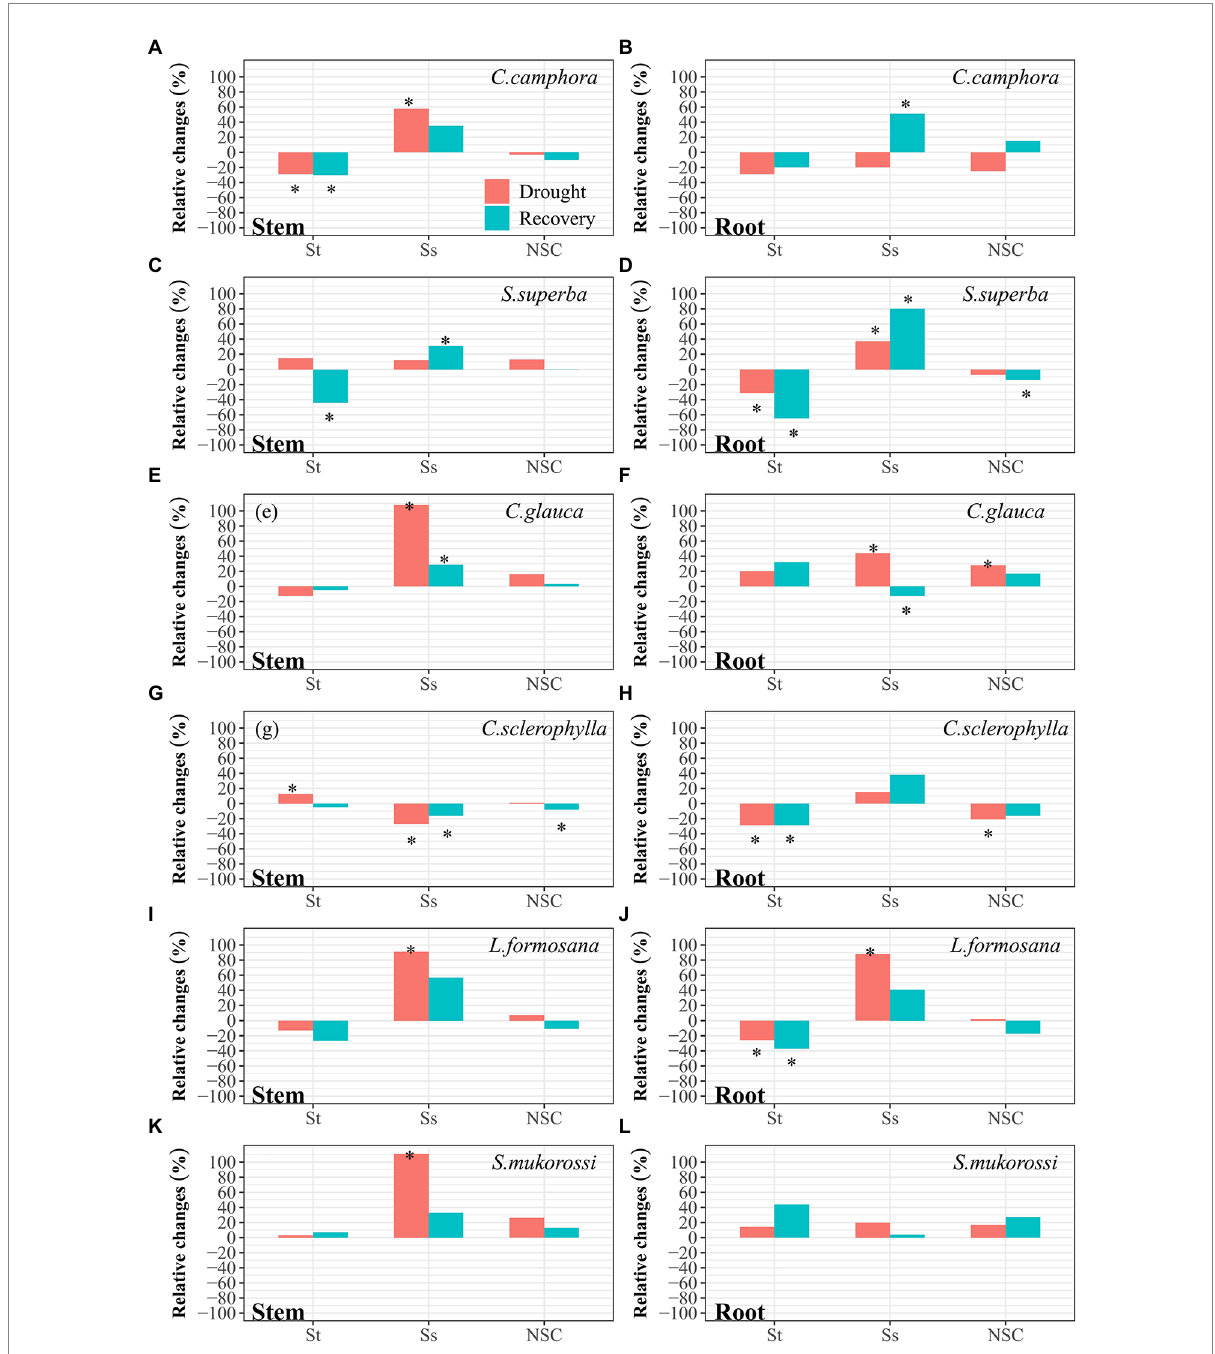
FIGURE 5 Relative changes of concentration of St, Ss and NSC in stems and roots for each species at peak drought (Drought) and 7 days after re-watering (Recovery) compared with pre-drought values. “ * ” means significant difference ( p ≤ 0.05). St, starch; Ss, soluble sugars; NSC, non-structural carbohydrates. The first four species are evergreen species, while the last two species are deciduous